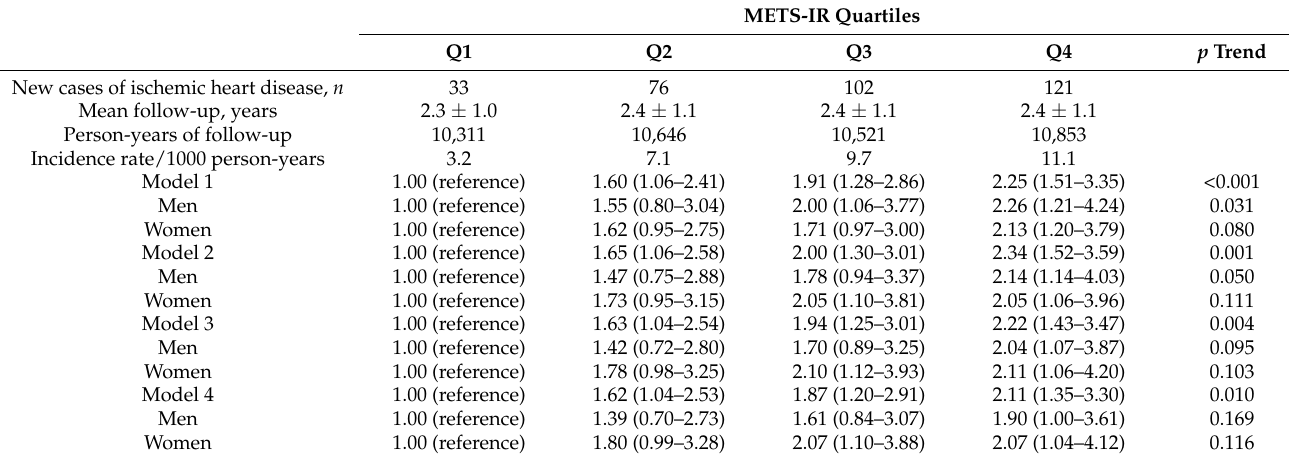
Table 2. Hazard ratios and 95% CIx for new-onset IHD according to METS-IR quartiles. METS-IR Quartiles Q1 Q2 Q4 p Trend